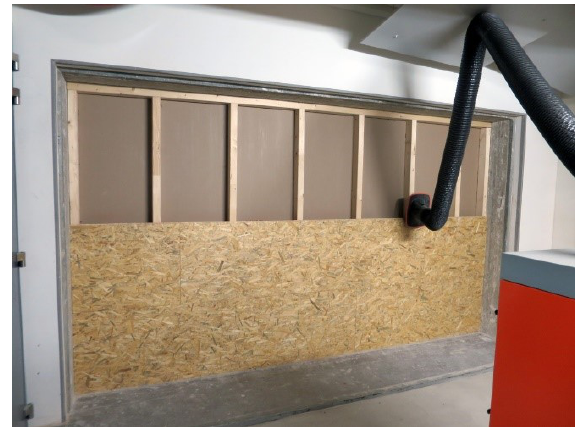
Figure 3. Filling the wall with crushed brick rubble (photo by K. Staněk).